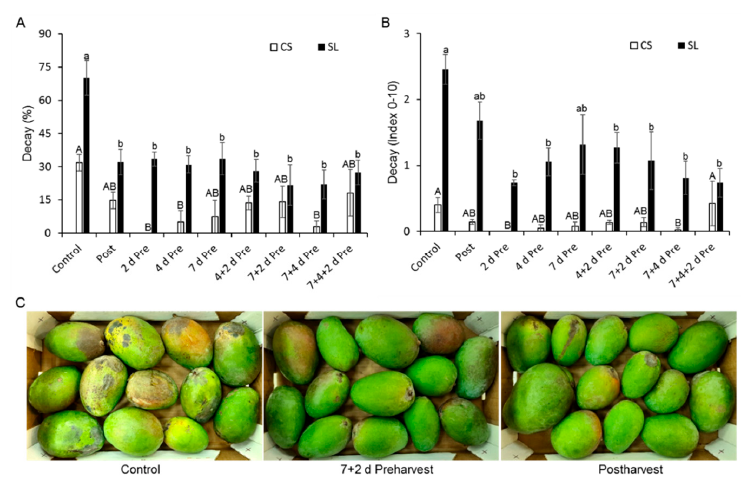
Figure 3. Effect of preharvest phenylalanine treatments on postharvest decay in mango. A “Keitt” mango orchard was sprayed preharvest (Pre) with water or 8 mM phenylalanine 2, 4, or 7 days (d)—or their combination—before harvest, or fruits were treated with 8 mM phenylalanine postharvest (Post). All the fruits were cold-stored (CS) at 12 °C for 14 d and then shelf life (SL)-stored at 22 °C for 10 d. ( A ) Incidence of natural decay (percentage). ( B ) Severity of natural decay (index, 0–10). ( C ) Representative pictures of mango fruits treated with 8 mM phenylalanine preharvest (7 + 2 d preharvest) or postharvest and controls, after shelf-life storage. Values are mean ± SE. Different letters indicate a significant difference between treatments at a specific time point (upper case letters for CS; lower case letters for SL) according to one-way ANOVA, p ≤ 0.05.